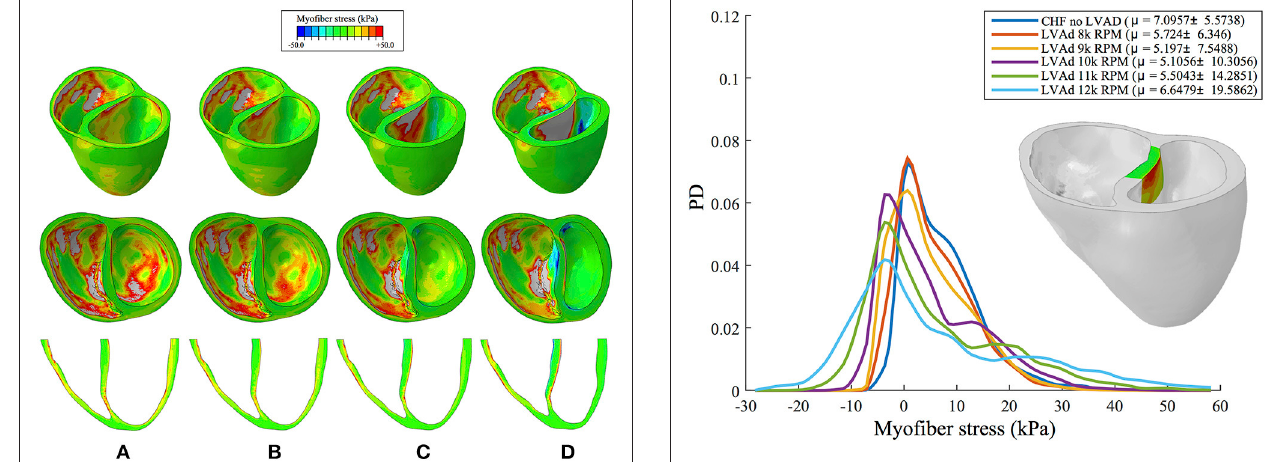
FIGURE 7 | Myofiber stress distributions at end diastole for the cases of (A) CHF with no LVAD support, (B) CHF with LVAD support running at 8k RPM, (C) , CHF with LVAD support running at 10k RPM, (D) CHF with LVAD support running at 12k RPM. Top row reveals a predominantly long-axis view of the biventricular structure, the middle row reveals a short-axis view, exposing the ventricular cavities, and the bottom row reveals a long-axis cut plane that bisects the ventricles. Light gray regions correspond to extreme stress values that exceed the threshold of + 50 kPa.